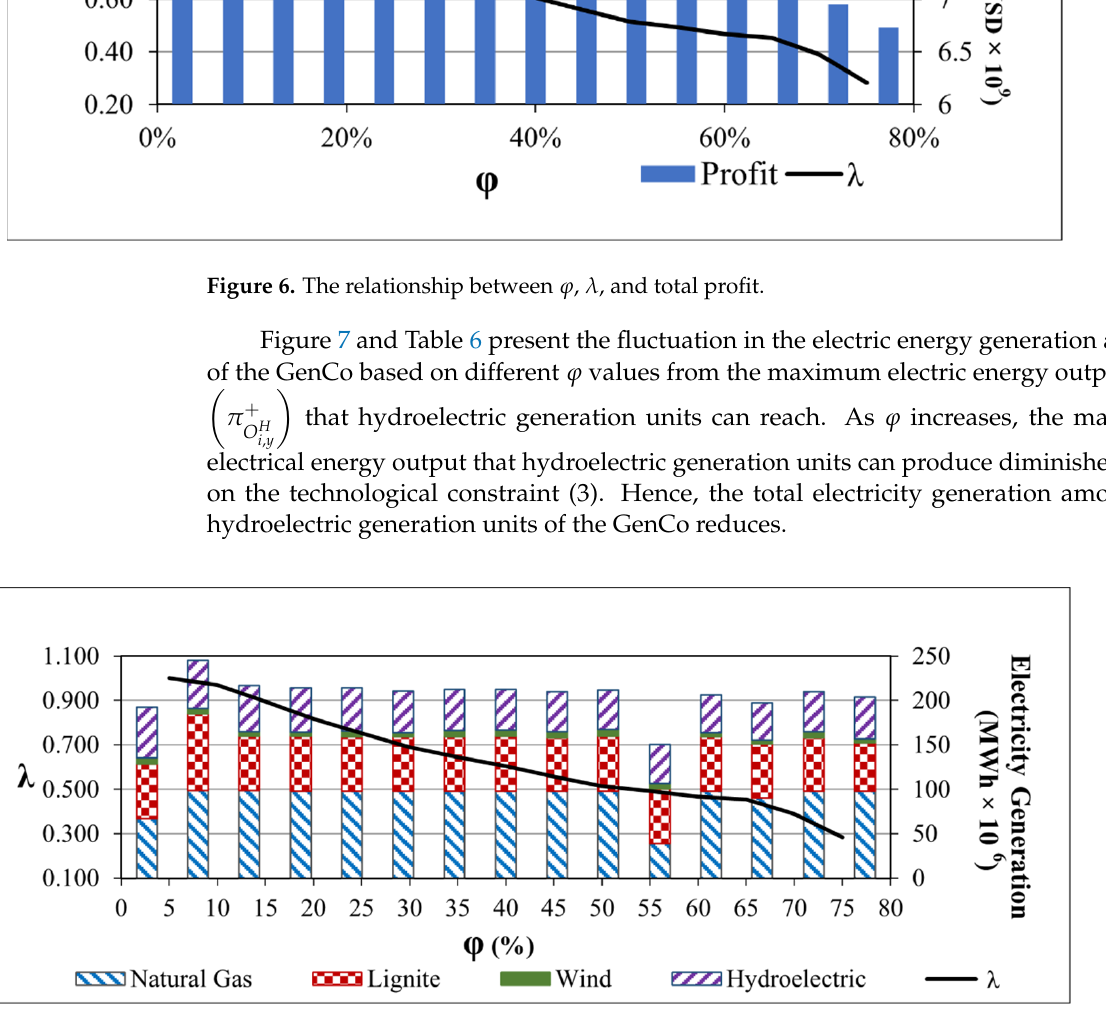
Figure 8. The relationship between φ , λ , and the electric energy wholesale market. Based on Table 6, as  values increase from 50% to 55%, the electricity generation (sale) amount of wind and lignite power plants decreases drastically. The losses in the total electricity generation from hydroelectric power plants impact negatively on total profitability, as well as the wind turbine and lignite power plant investments diminish. Hence, the negative effects of the drop in the total investment costs and the total operation costs, and the reduction in the electric energy output level of hydroelectric power plants are reduced on total profitability. Table 7 and Figure 9 provide the relationship between  and λ values and candi ‐ date generation unit investments. Figure 10 presents the change in the total installed ca ‐ pacity of the GenCo based on different  and λ values. As the fuzziness in  increases, the maximum electrical energy output that hydro ‐ electric generation units diminish based on the technological constraint (3). As the total electricity generation amount for hydroelectric units of the GenCo and the sales income value decreases, so does the total profit (see Table 6). In order to compensate for the